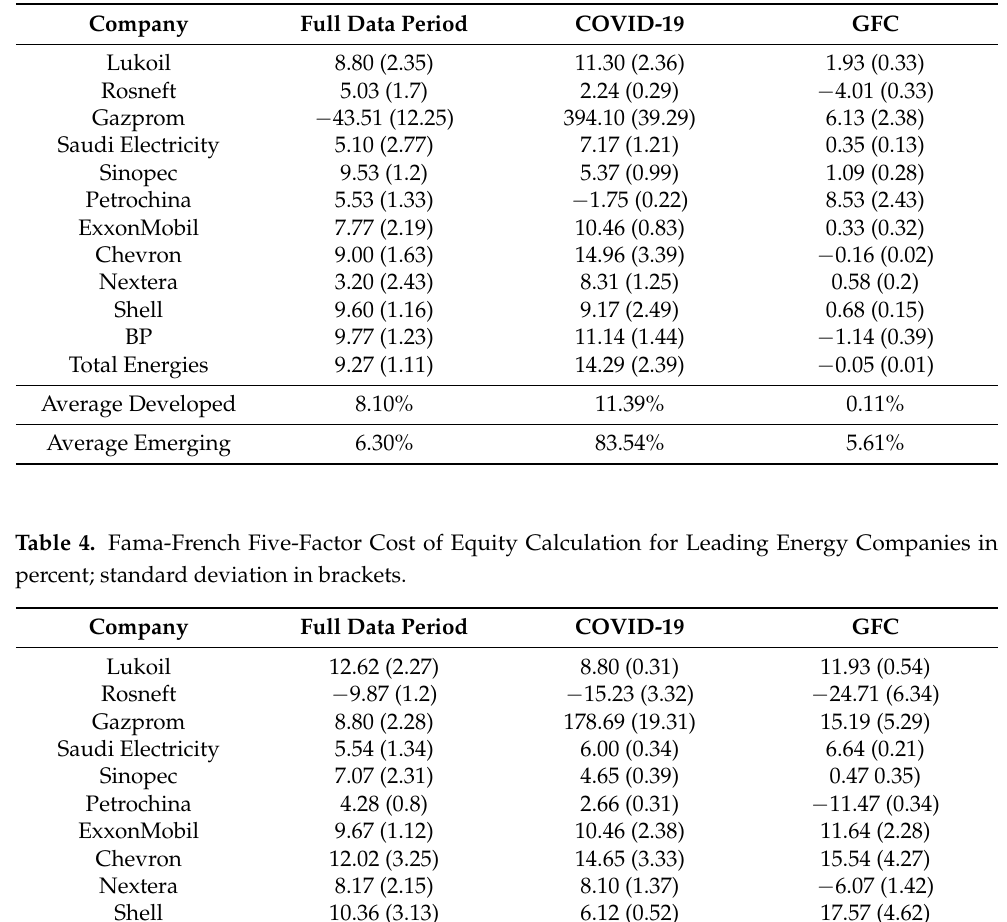
Table 3. Fama-French Three-Factor Cost of Equity Calculation for Leading Energy Companies in percent; standard deviation in brackets.